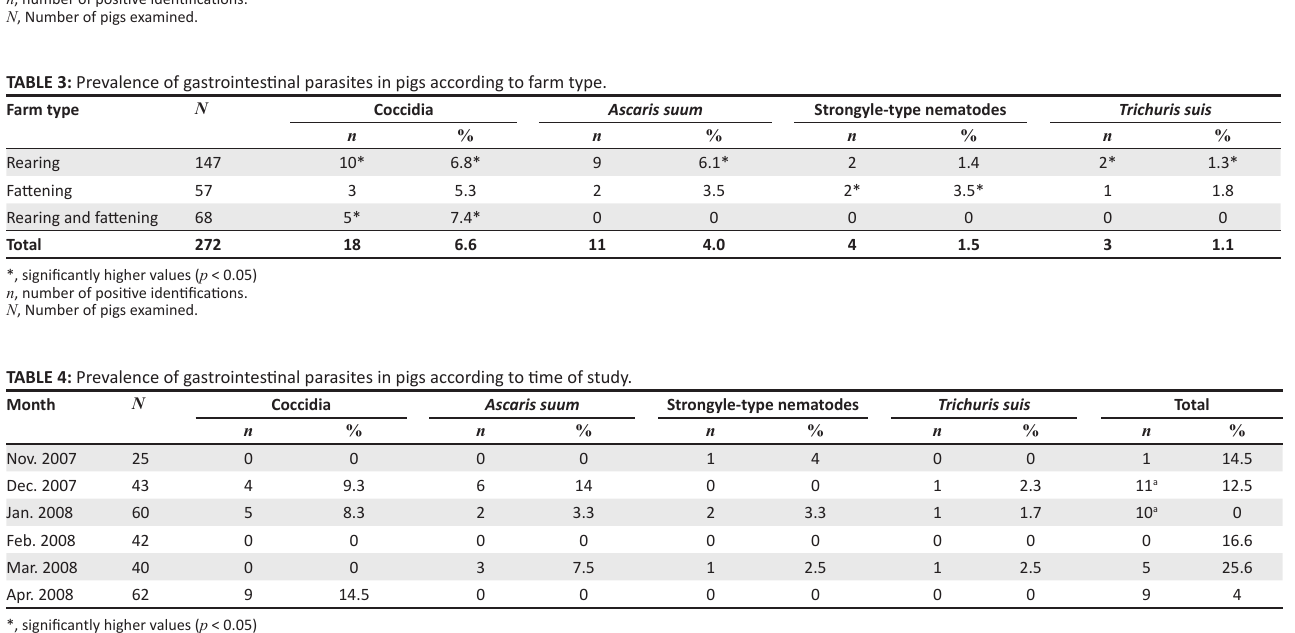
TABLE 3: Prevalence of gastrointestinal parasites in pigs according to farm type. Farm type